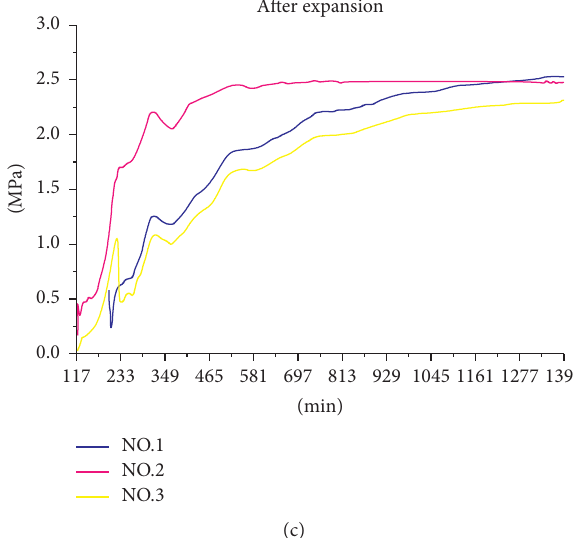
Figure 10: Stress variation of three measuring points under three states: (a) stress variation diagram of three measuring points at the top corner of the roadway before mining; (b) stress variation diagram of three measuring points at the top angle of the roadway end in normal mining; (c) stress variation diagram of three measuring points at the top corner of the end in mining after cutting and reinforcement of the anchor